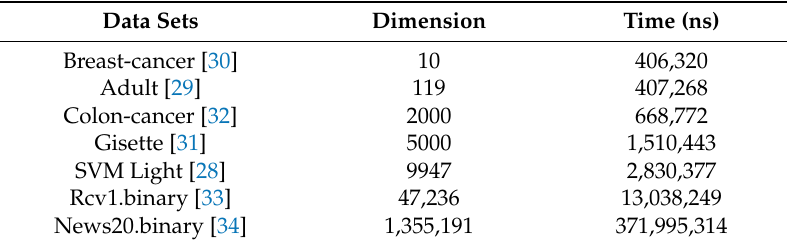
Table 2. Time comparison of changeable-dimension Matrix Computing.